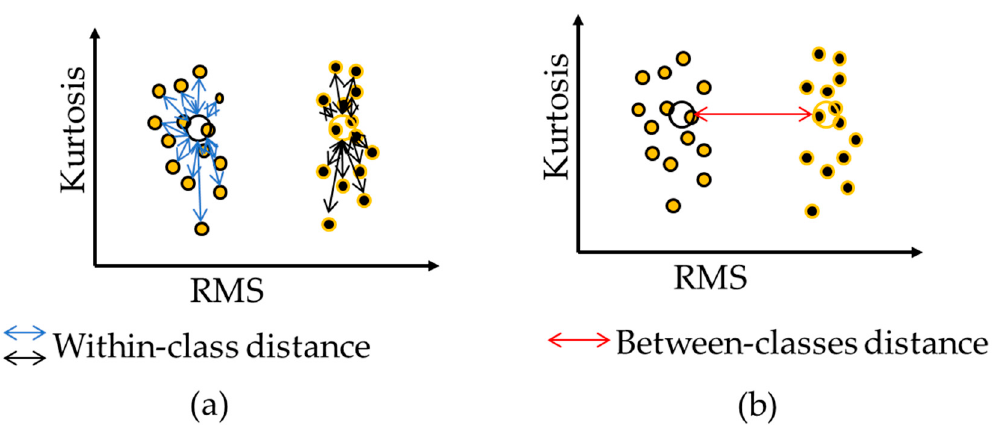
Figure 7. The fitness function calculation for a genetic algorithm (GA): ( a ) shows the within-class distance measure and ( b ) shows the distance measure of the between classes. In the figure, big circles indicate the center median of each class.